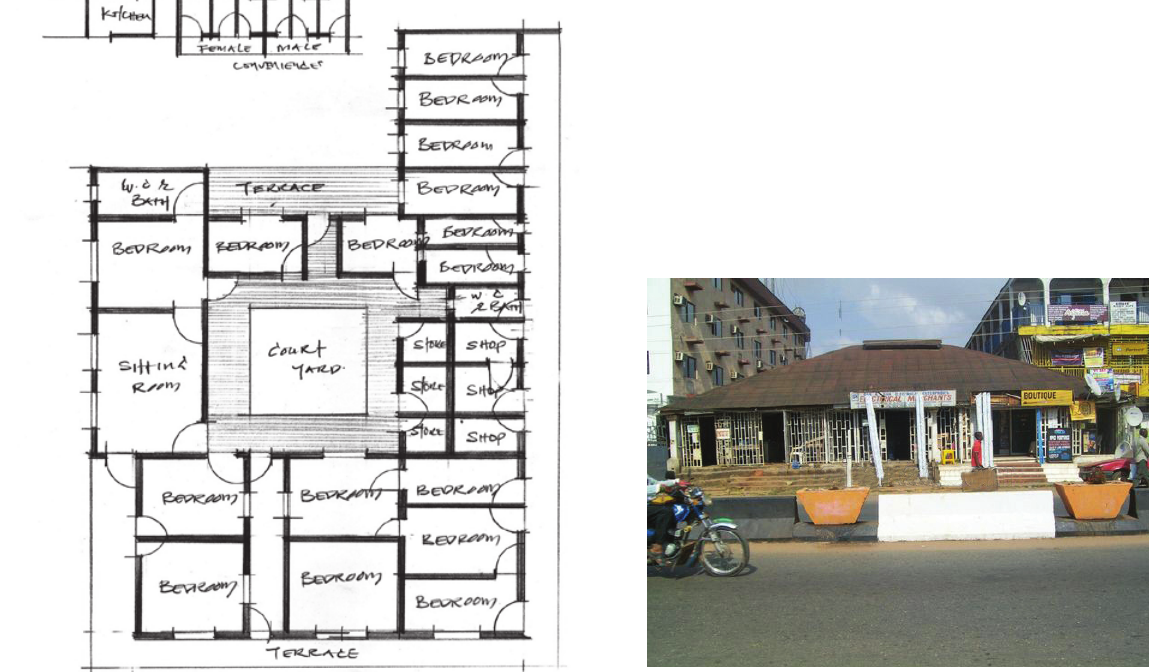
Fig. 5. a Typical modified family-compound Benin house Source: Ekhaese (2011).